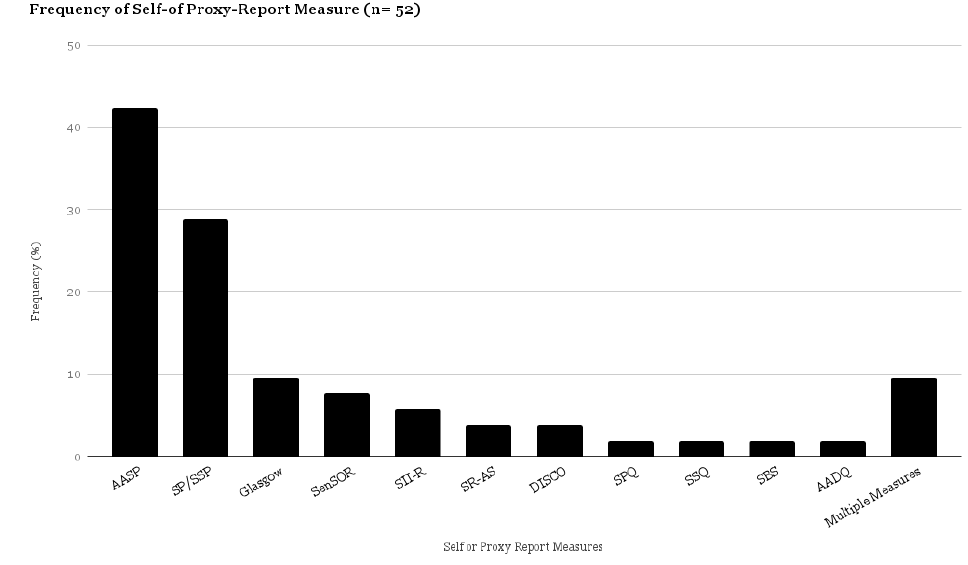
Figure 5. Proportional Table–Questionnaires ( n = 52).